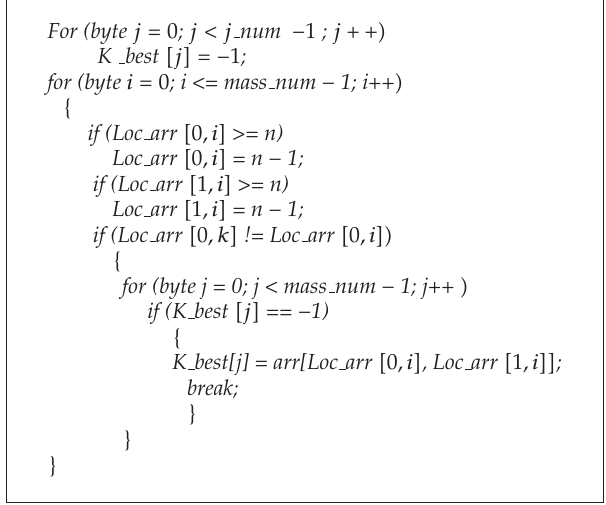
Algorithm 1: First condition: unparallelism of two